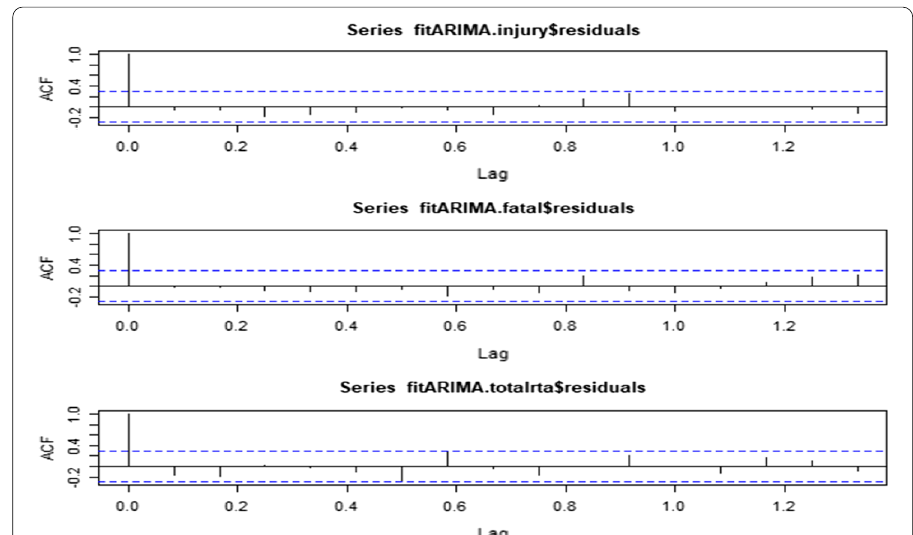
Fig. 6 Diagnostics of residuals for ARIMA of injury, fatal, and total RTA data